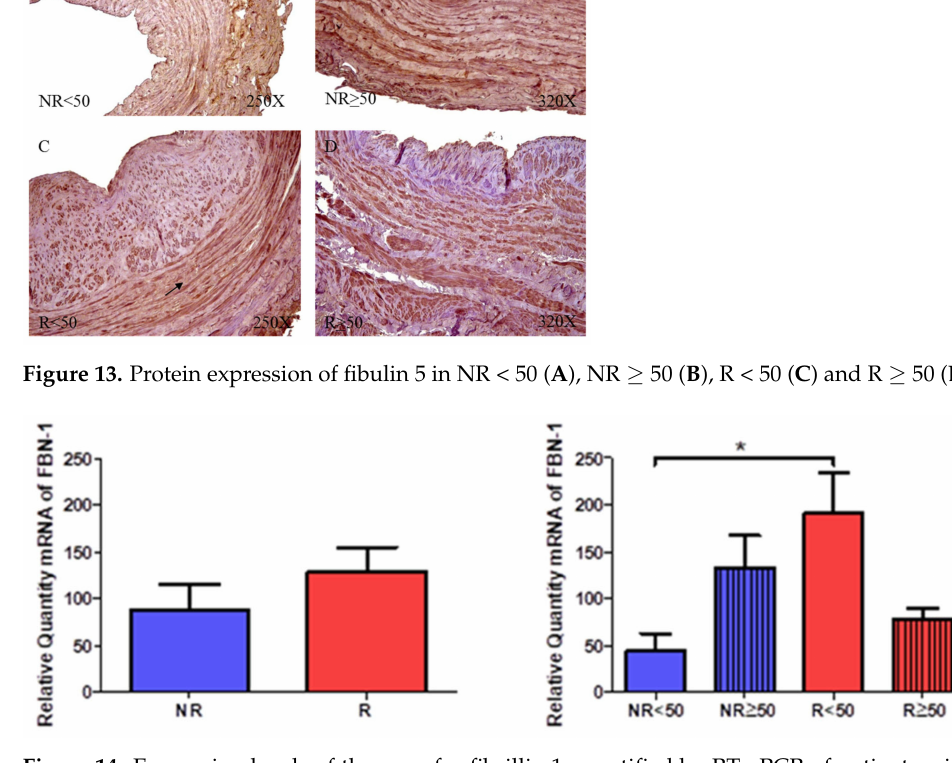
Figure 14. Expression levels of the gene for fibrillin 1 quantified by RT-qPCR of patients without reflux (NR) and with reflux (R), as well as by their ages. * p <